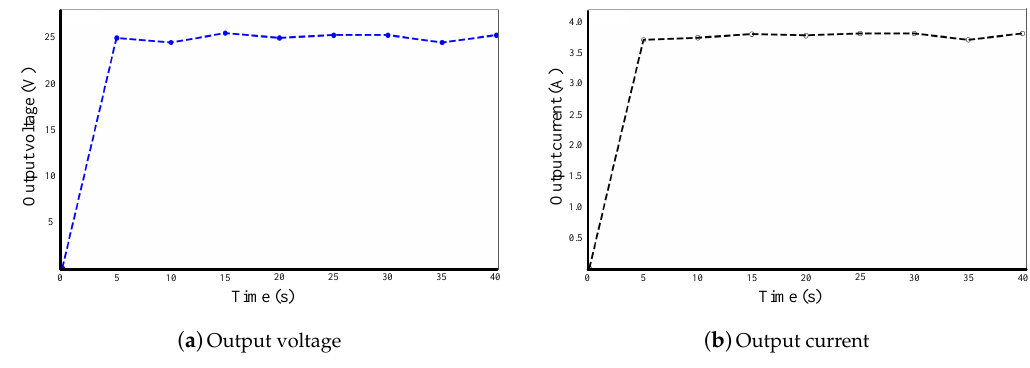
Figure 9. DC output values of the harvesting solar